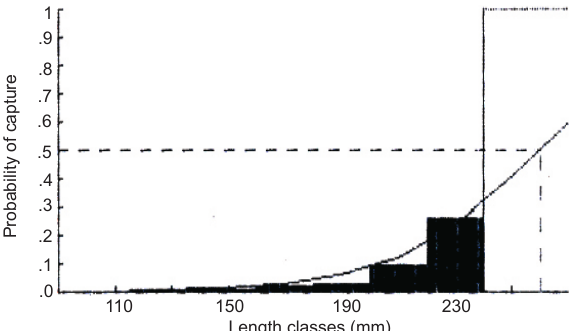
Figure 6. Probabilities of capture pattern of Horabagrus brachysoma from Periyar River